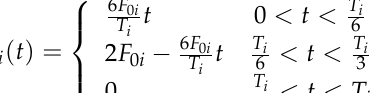
where T i is the i -th ice force cycle size and F 0 i is the ice force amplitude in the cycle. On the basis of Equation (5), a random ice force function of any length of time can be extended: 0